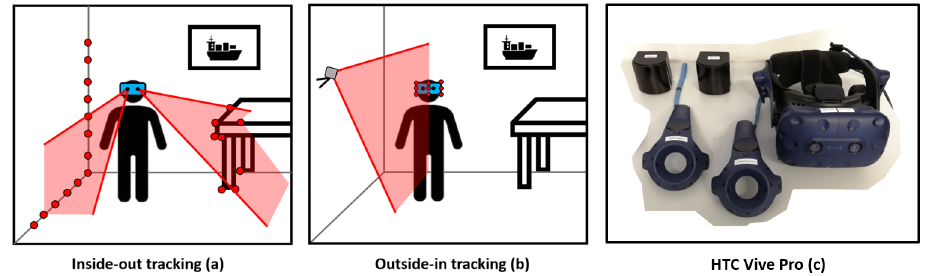
Figure 1. Different tracking procedures ( a , b ) and system components ( c